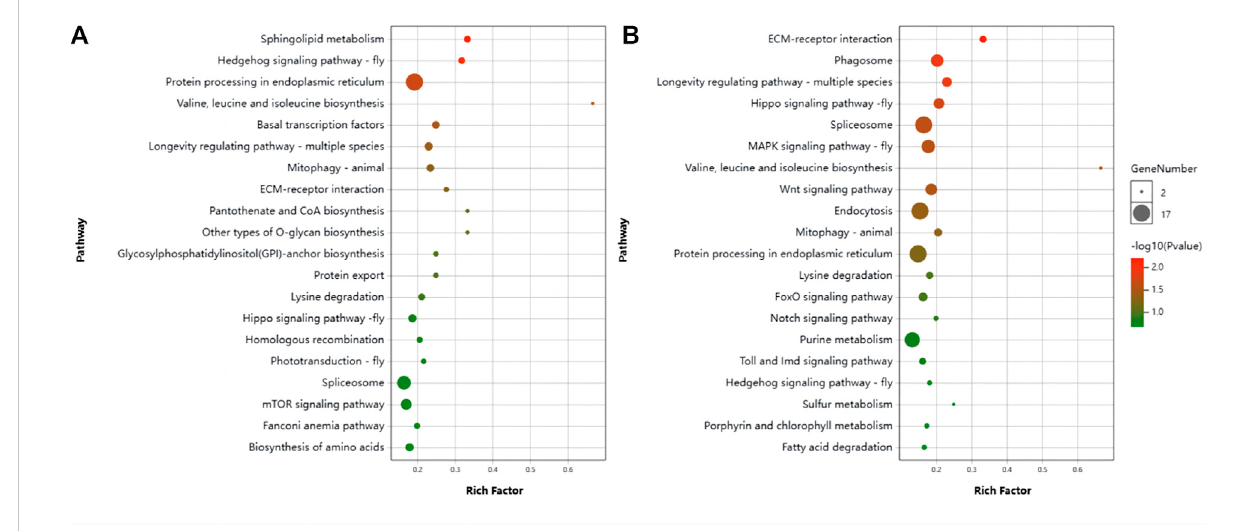
FIGURE 6 Scatter plot of KEGG pathway enrichment by differentially expression genes (DEGs). (A) Control vs. T24. (B) Control vs.